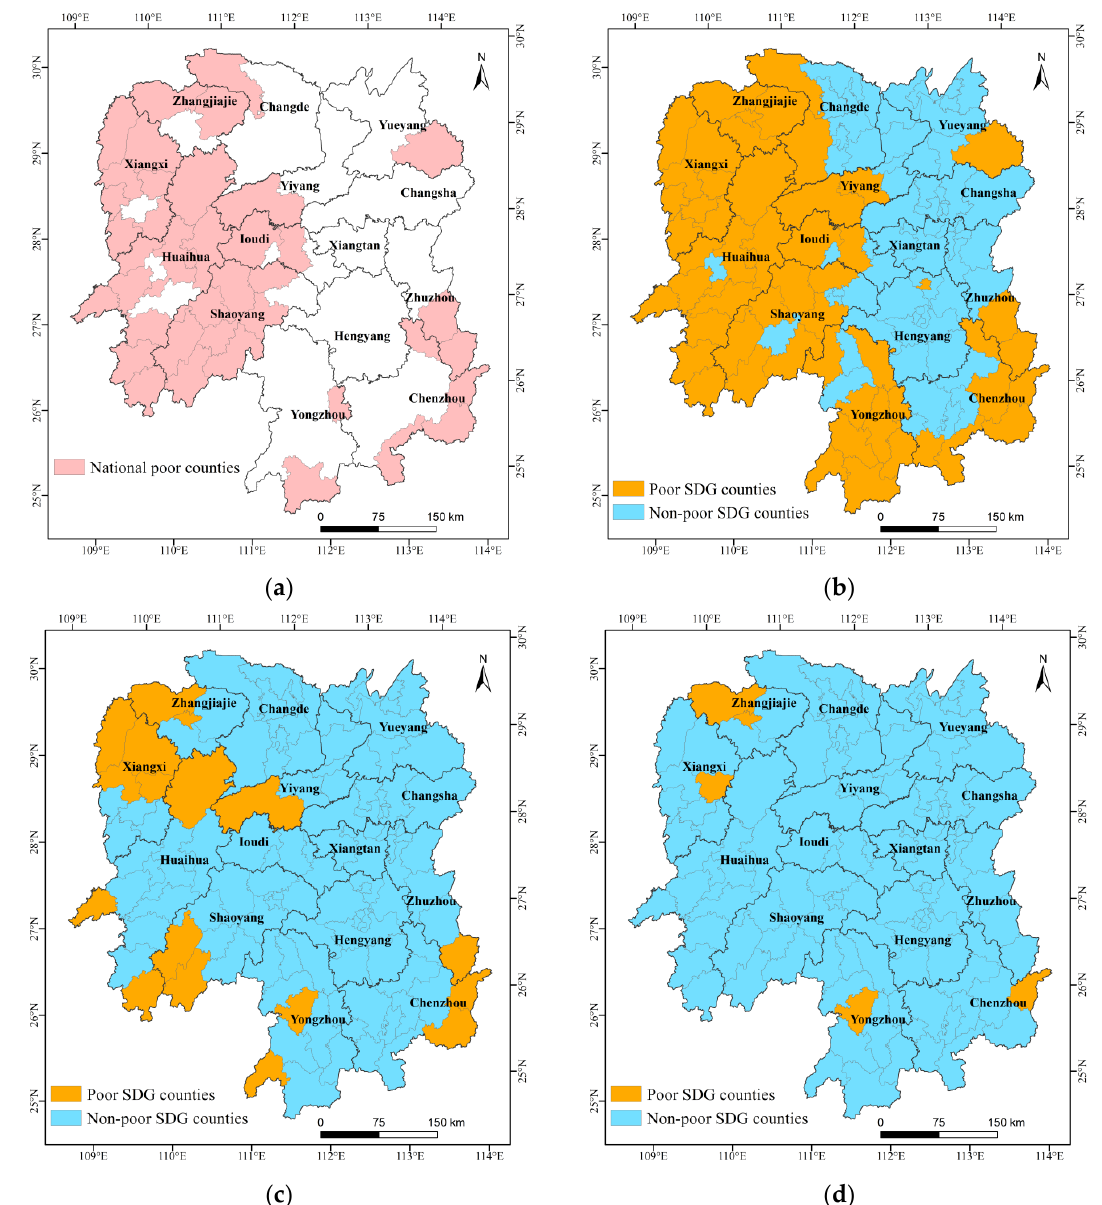
Figure 8. ( a ) Distribution of NPCs in China; ( b – d ) are the spatial distributions of poor SDG counties in Hunan Province in 2014, 2016 and 2018, respectively.